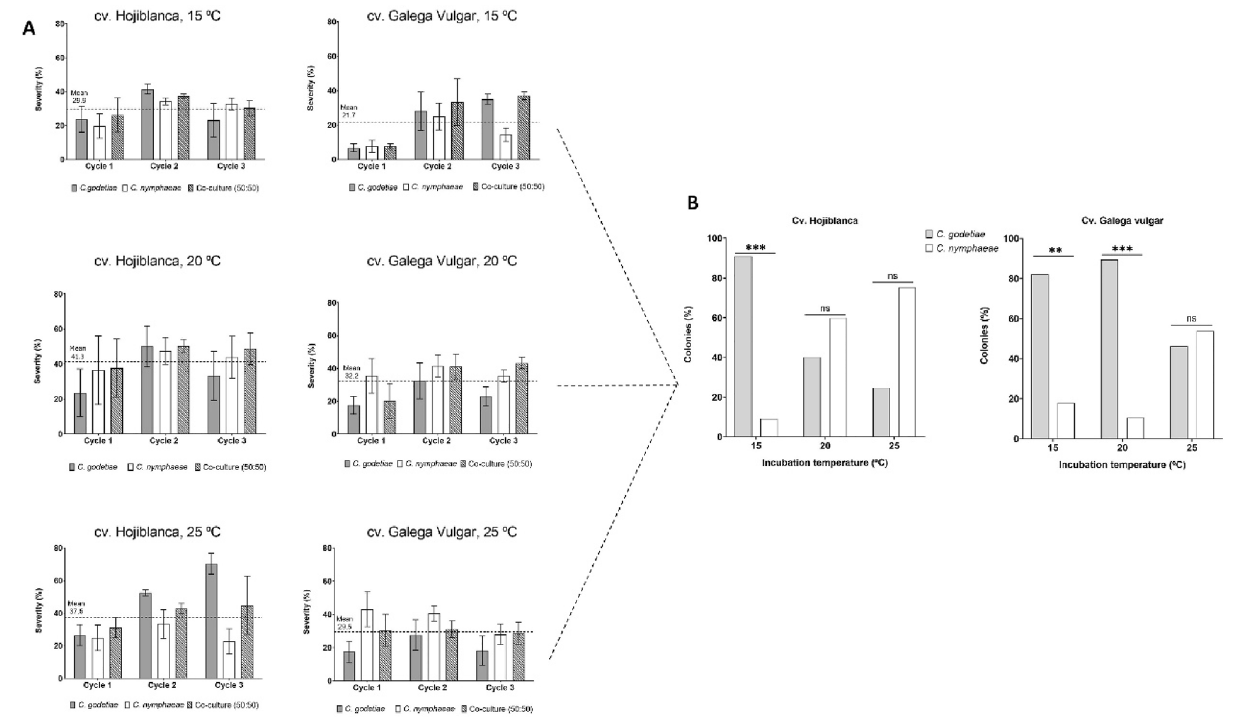
Figure 2. ( A ) Disease severity (Mean and Standard Deviation values by grouping the two repetitions conducted), evaluated as the relative Area Under the Disease Progress Curve (rAUDPC), of olive fruits of cultivars Hojiblanca and Galega Vulgar inoculated with conidial suspensions of Colletotrichum godetiae , C. nymphaeae , and a mixture of both species (50:50), and incubated at 15, 20 and 25 °C. ( B ) Colonies (%) of C. godetiae and C. nymphaeae from affected olive fruits of cvs. Hojiblanca and Galega Vulgar co-inoculated with a mix (50:50%) of spores of both species and incubated at 15, 20 and 25 °C. Significant differences